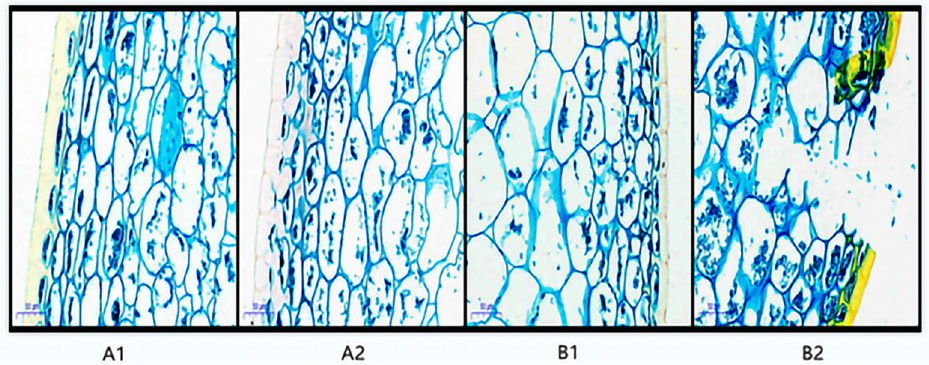
Figure 2. Paraffin section of pepper before and after storage. Annotation: A1 represents A144 material stored for 0 days; A2 represents A144 material stored for 3 days; B1 represents A361 material stored for 0 days; B2 represents A361 material stored for 3 days.